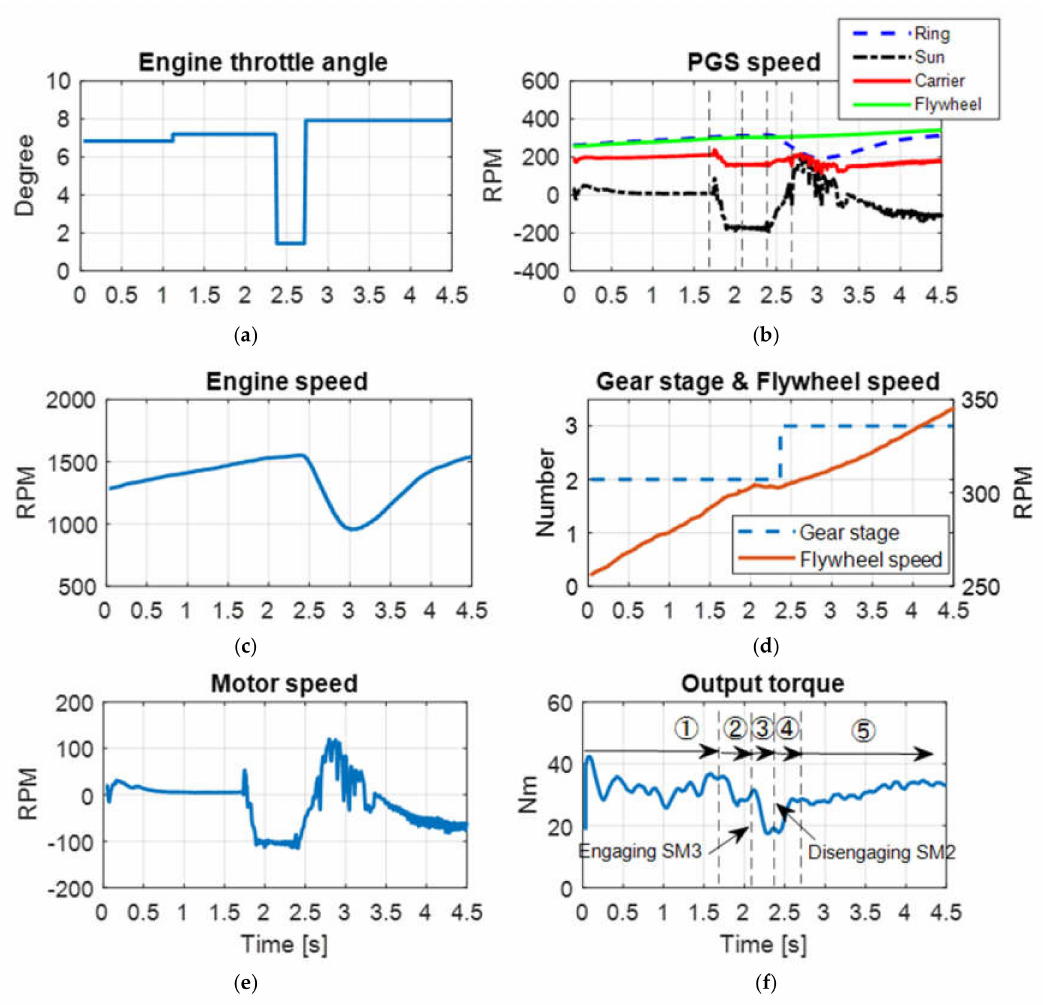
Figure 15. Experimental results of shifting from even to odd gear-shift (from 2nd to 3rd): ( a ) Engine throttle angle; ( b ) PGS speed; ( c ) Engine speed; ( d ) Gear stage and flywheel speed; ( e ) Motor speed; (f) Output torque during shifting phases ( 1 (cid:79) 2nd gear driving, 2 (cid:79) Speed synchronization, 3 (cid:79) Torque control, 4 (cid:79) Engine speed adjustment, 5 (cid:79) 3rd gear driving). Shifting times are summarized in Table 4. The average elapsed time for gear-shift is 0.71 s. It is